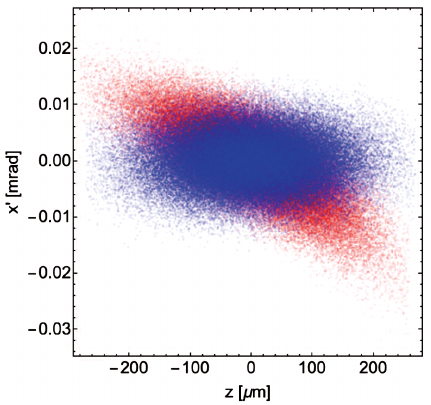
FIG. 4. Transverse phase spaces at the exit of TCBC at 250 MeV beam energy in the linear (blue) and nonlinear regime (red) for the optimal Twiss parameters β x;y ¼ 59 m and α x;y ¼ 2 . 1